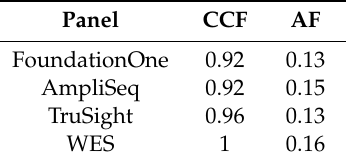
Table 2. Thresholds used to determine the clonality of the